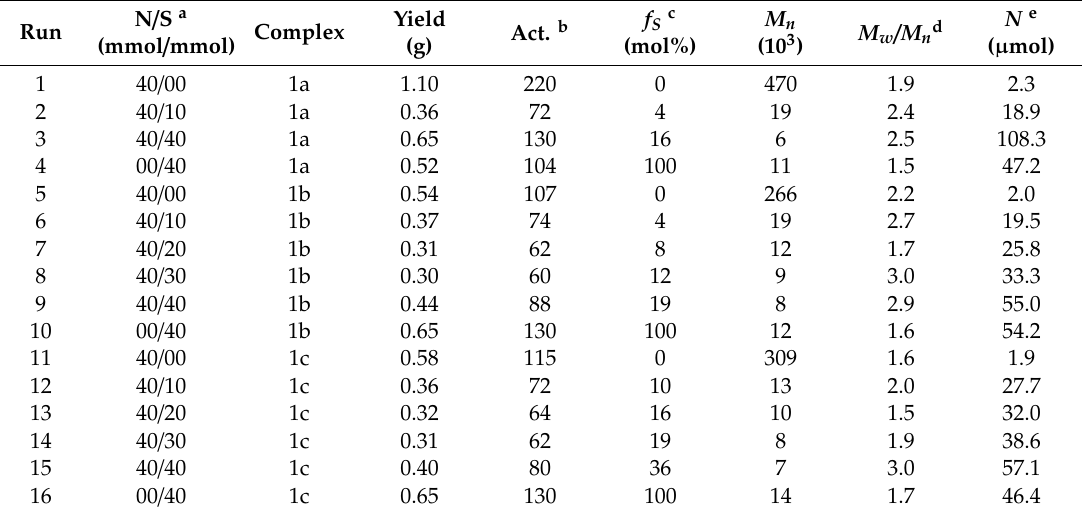
Table 1. E ff ects of monomer ratio of norbornene (N) / styrene (S) copolymerization by 1 -MMAO. N / S a Yield Run Complex (mmol / mmol)